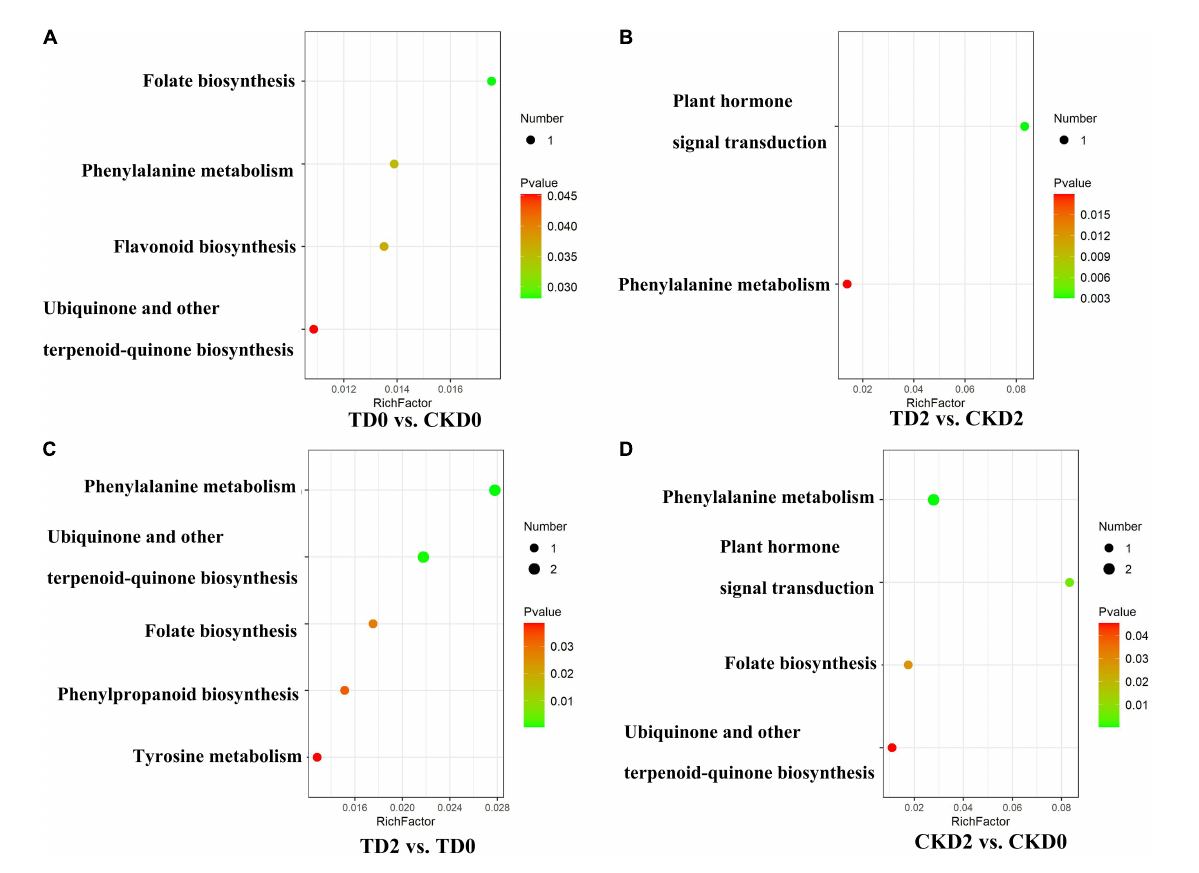
FIGURE6 Encyclopaedia of Genes and Genomes (KEGG) enrichment plots of differential metabolites, (A–D) among comparison groups, including TD0 vs. CKD0, TD2 vs. CKD2, TD2 vs. TD0 and CKD2 vs. CKD0. The horizontal coordinate indicates the enrichment factor corresponding to each pathway; the vertical coordinate is the pathway name and the color of the dot is the p -value. The red intensity of the dot increases as the significance of the enrichment increases. The size of these dots represents the number of differential metabolites